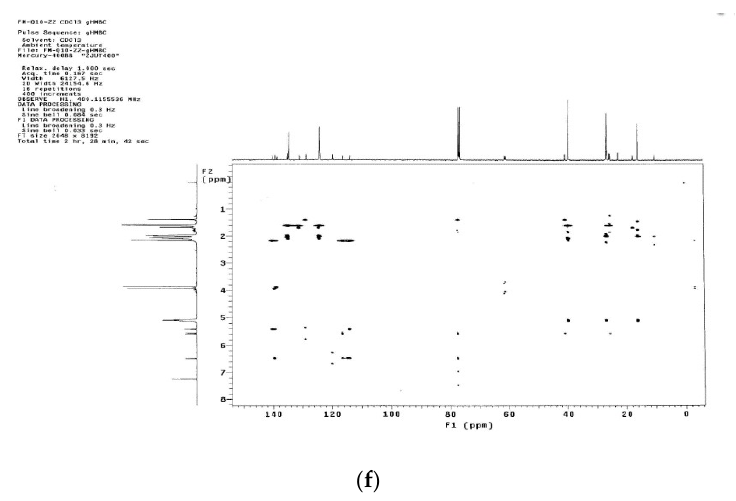
Figure 8. ( a ) H-NMR spectrum of impurity X; ( b ) C-NMR spectrum of impurity X; ( c ) DEPT spectrum of impurity X; ( d ) gCOSY spectrum of impurity X; ( e ) gHSQC spectrum of impurity X; ( f ) gHMBC spectrum of impurity X.